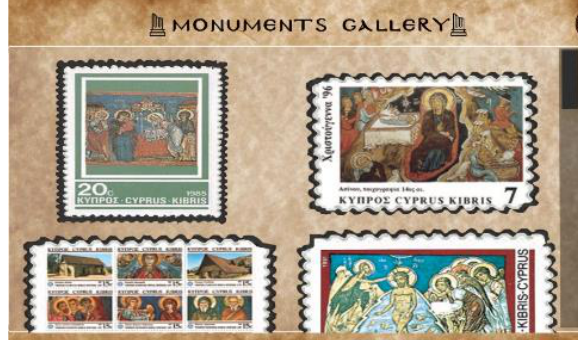
Figure 14. The gallery rewards related with the monument such as stamps (Apsida, 2021a).